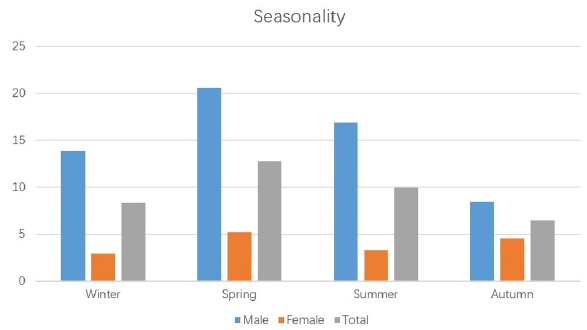
Fig. 5. Seasonality of the suicide (cases per 100,000 popula-